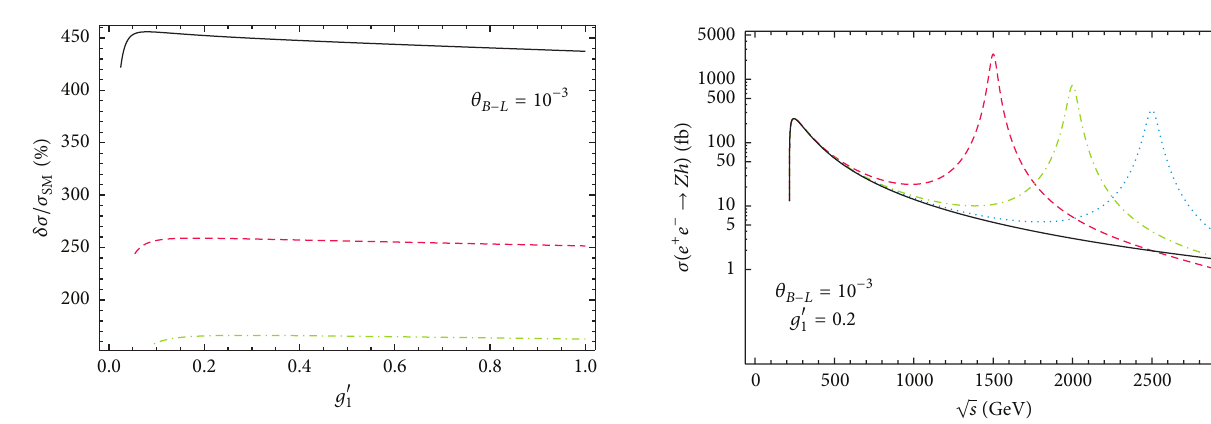
Figure6:Therelativecorrection 𝛿𝜎/𝜎 SM asafunctionof 𝑔 󸀠 1 .Starting from the top, the curves are for 𝑀 𝑍 󸀠 = 1500 , 2000 , 2500 GeV and √𝑠 = 1500 , 2000 , 2500 GeV, respectively.